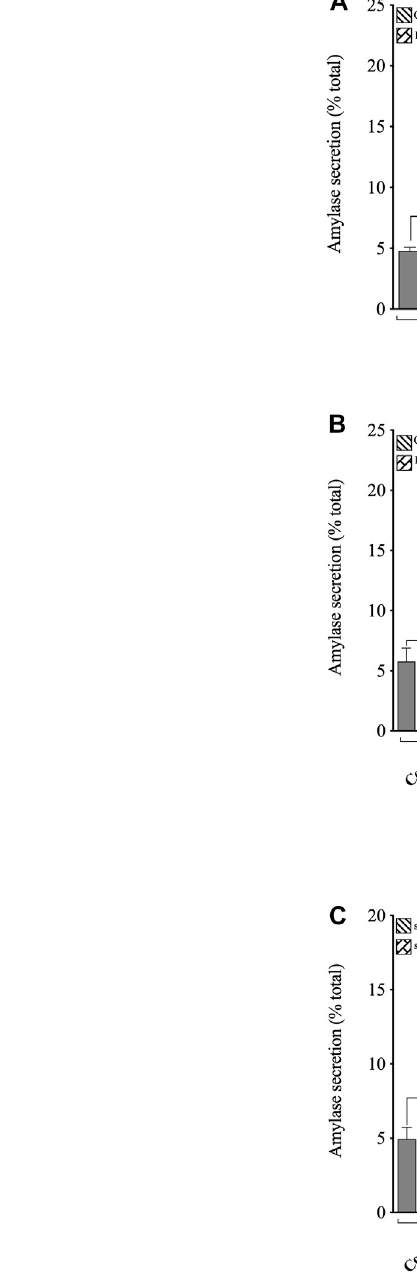
allowed a comparative SSH1 siRNA study to also be performed (Figure 3). In CCK 1 -R/Panc-1 cells, similar to pancreatic acini, both concentrations of CCK-8 (0.3 and 100 nM) caused rapidly dephosphorylation of co fi lin (i.e., activation) (Figure 3C). In